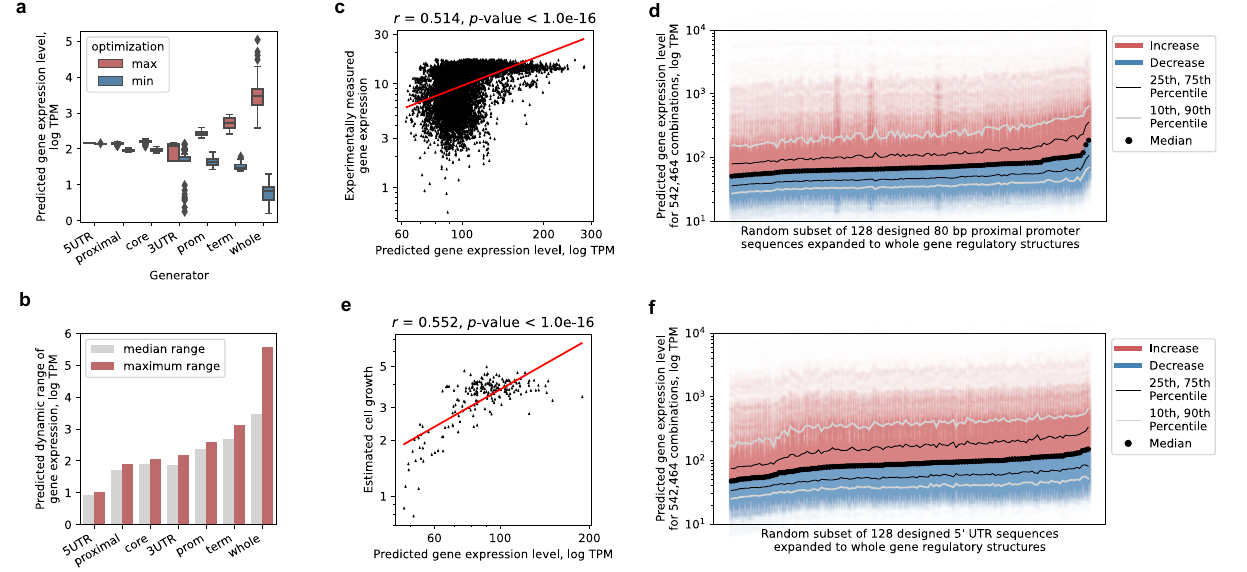
with a random subset of the 80bp proximal promoter designs 15 when expanded and combined with all 4238 native gene regulatory structures to create 1000bp constructs ( n =542,464). Black dots denote median levels, black lines the inter- quartile range and gray lines the 10th and 90th percentiles, respectively. e Correlation analysis between published estimated cell growth of 5 ′ UTR designs (at the optimal level of evolutionary rounds) 24 and our predicted gene expression levels ( n =200). Red line denotes the least-squares fi t. The T -test was used. f Increases (red) and decreases (blue) of gene expression levels with a random subset of the 5 ′ UTR designs 24 when expanded and combined with all 4238 native gene regulatory structures to create 1000bp constructs ( n =542,464). Black